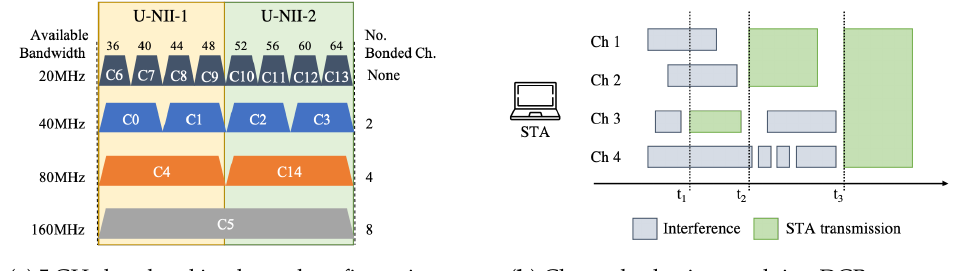
Figure 1. CB problem’s complexity is exacerbated by its combinatorial nature and the applied transmission